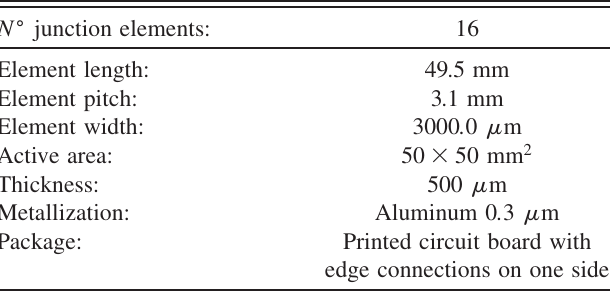
TABLE I. Data sheet of the W1(SS)-500 detector provided by Micron Semiconductor Ltd. [8]